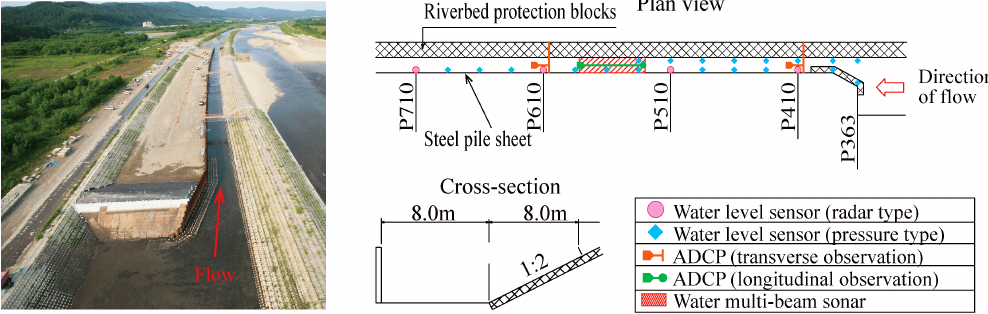
Fig. 1. View of experiment flume and hydraulic observation position.